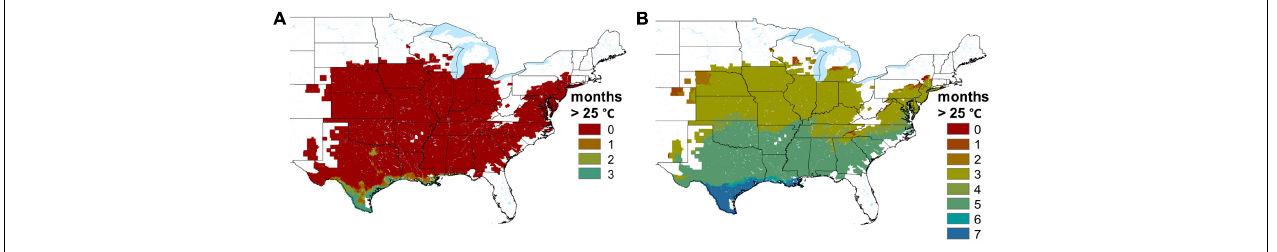
FIGURE 5 | Map showing the number of months that average A. crepitans body temperatures are predicted to exceed (A) 25 ◦ C, the approximate thermal maximum for the Bd pathogen (Voyles et al., 2017), and (B) 17 ◦ C, the temperature below which A. crepitans is most susceptible to Bd (Sonn et al.,